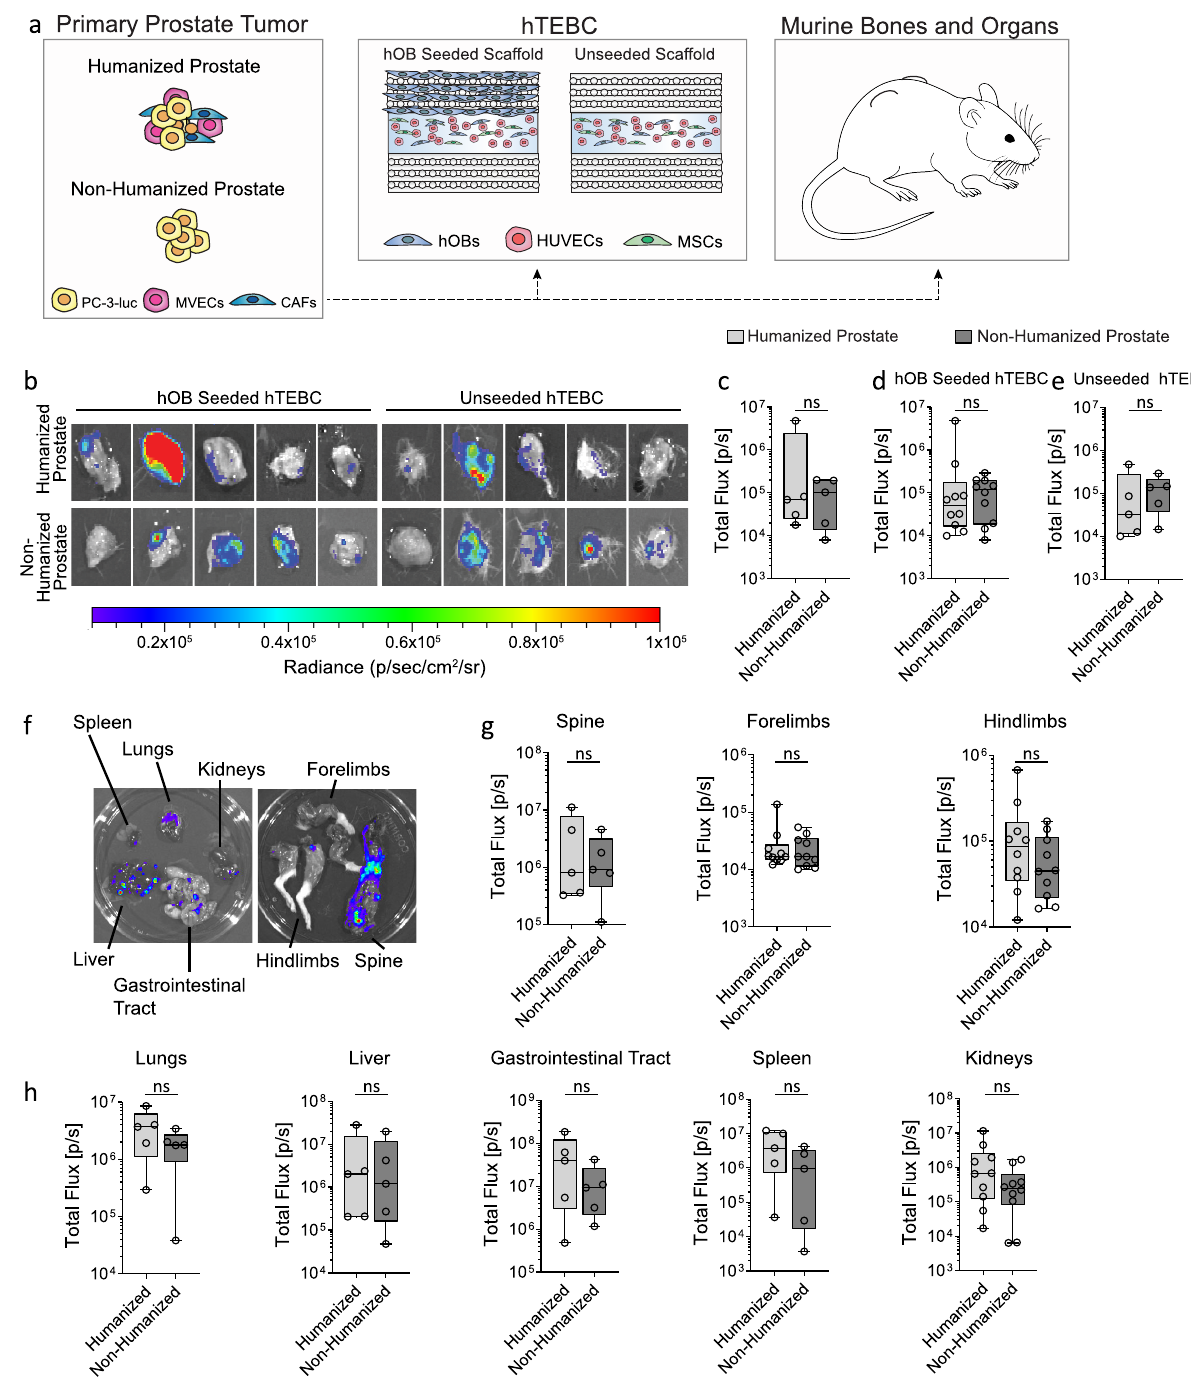
Fig. 5 Metastasis of PC-3-luc cells from the primary prostate tumor to the hTEBC, murine bones, and organs. a Overview of the different levels of humanization within the in vivo model. The prostate was humanized by co-injection of PC-3-luc, BVECs, and CAFs into the murine prostate. The back of the mice received humanized bone constructs with scaffolds seeded or unseeded with hOBs. The murine bones and organs, in addition to the hTEBCs were analyzed for PC-3-luc metastases. b Representative ex vivo bioluminescent images (BLI) of the hTEBCs with PC-3-luc PCa metastases and c quanti fi cation of the BLI data from PC-3-luc cells which had metastasized from the primary prostate tumor to all hTEBC (data from hOB seeded and unseeded hTEBC combined, n = 10 hTEBC from fi ve mice with two scaffolds each). d Quanti fi ed BLI data were grouped based on metastasis of PC-3-luc cells to the hOB- seeded scaffold (left-back only; n = 5 hTEBCs from fi ve mice), or e the unseeded scaffold (right-back only; n = 5 hTEBCs from fi ve mice). f PCa metastases were present in murine organs and bones as indicated by ex vivo BLI. g No signi fi cant differences in metastasis from the humanized or non-humanized prostate tumors to the murine bones; spine, forelimbs, or hindlimbs. h No signi fi cant differences in metastasis to the murine organs; lungs, liver, gastrointestinal tract, spleen, or kidneys. Data are represented as box plots depicting the median, fi rst and third quartile, minimum and maximum, and are overlaid with individual data points. All hTEBC, lung, and spleen BLI data were normally distributed and analyzed using an unpaired t -test. The hOB seeded and unseeded hTEBC, spine, forelimb, hindlimb, liver, gastrointestinal tract, and kidney BLI data were not normally distributed and were analyzed using a Mann − Whitney test. The mouse schematic image was sourced from Wikimedia Commons 52